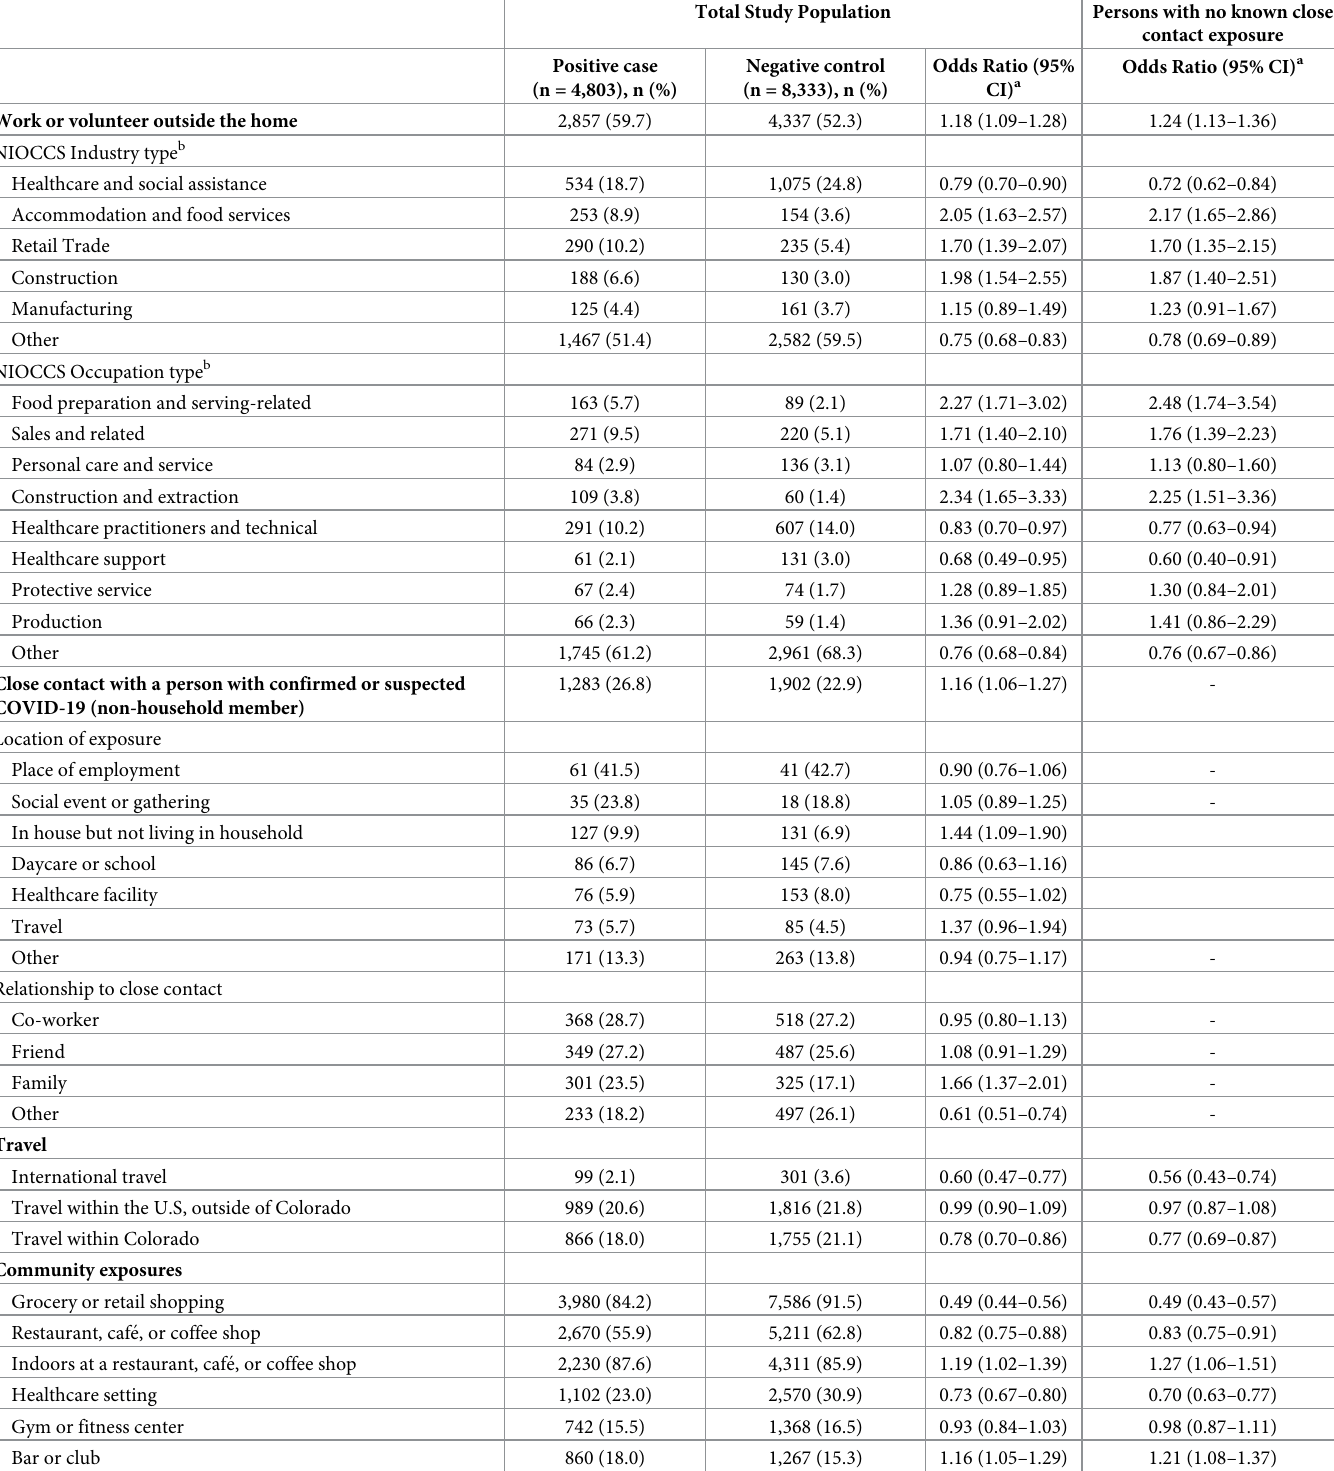
Table 2. Community and workplace exposures of symptomatic Colorado adults aged � 18 years with confirmed COVID-19 compared to persons testing negative for COVID-19 –specimen collection dates from March 16 to December 23,